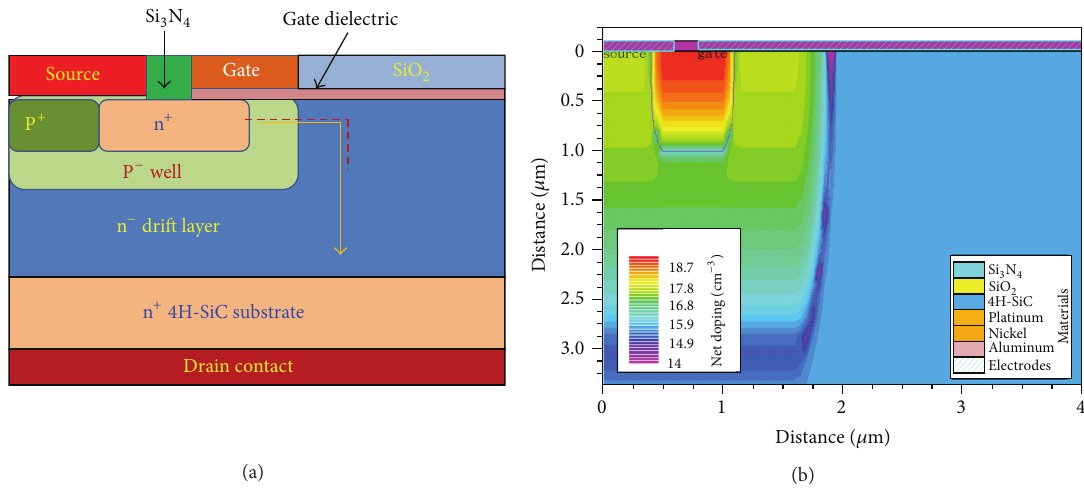
Figure 2: A schematic cross section of simulated device layer structure (a) and corresponding net doping profile showing top portion of 4H-SiC based MOSFET (b).